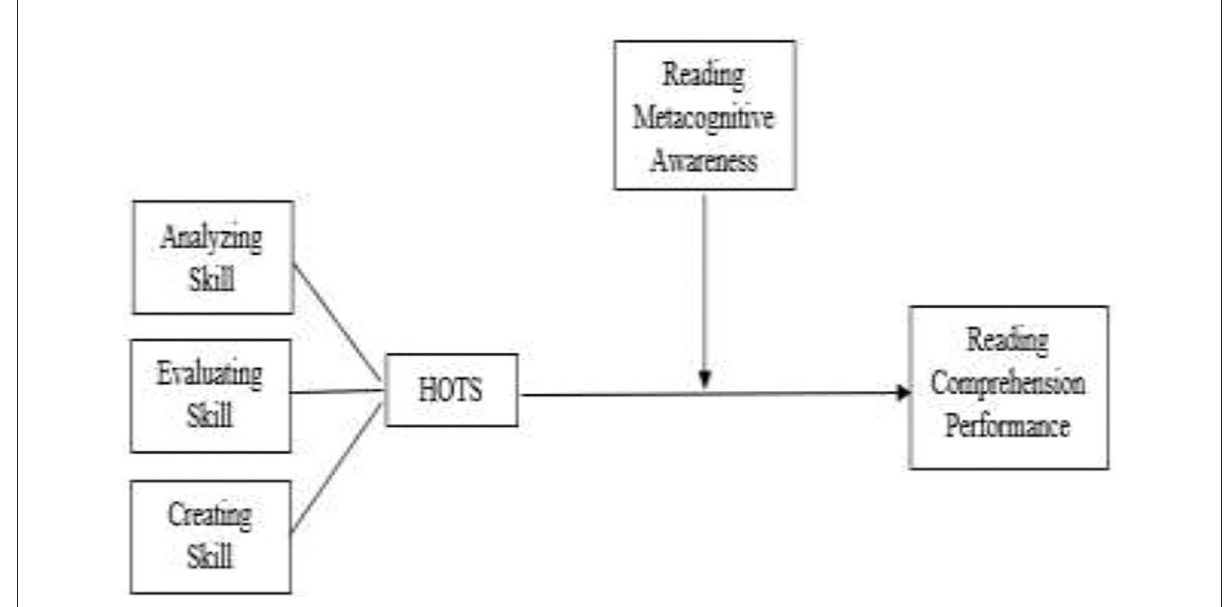
FIGURE2 Theoretical framework of the